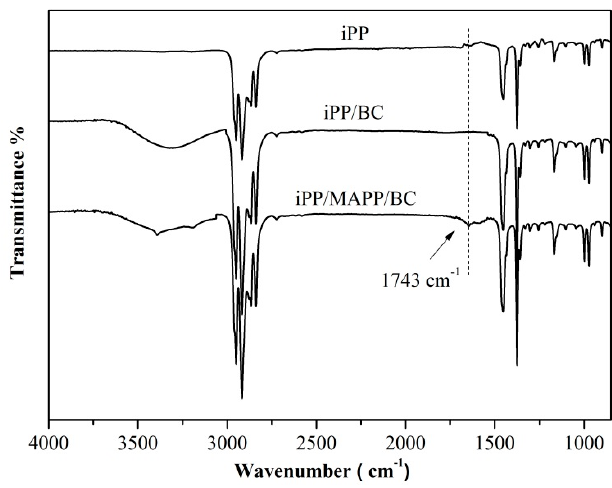
Figure 6. FTIR of the iPP/BC hamburger composite.